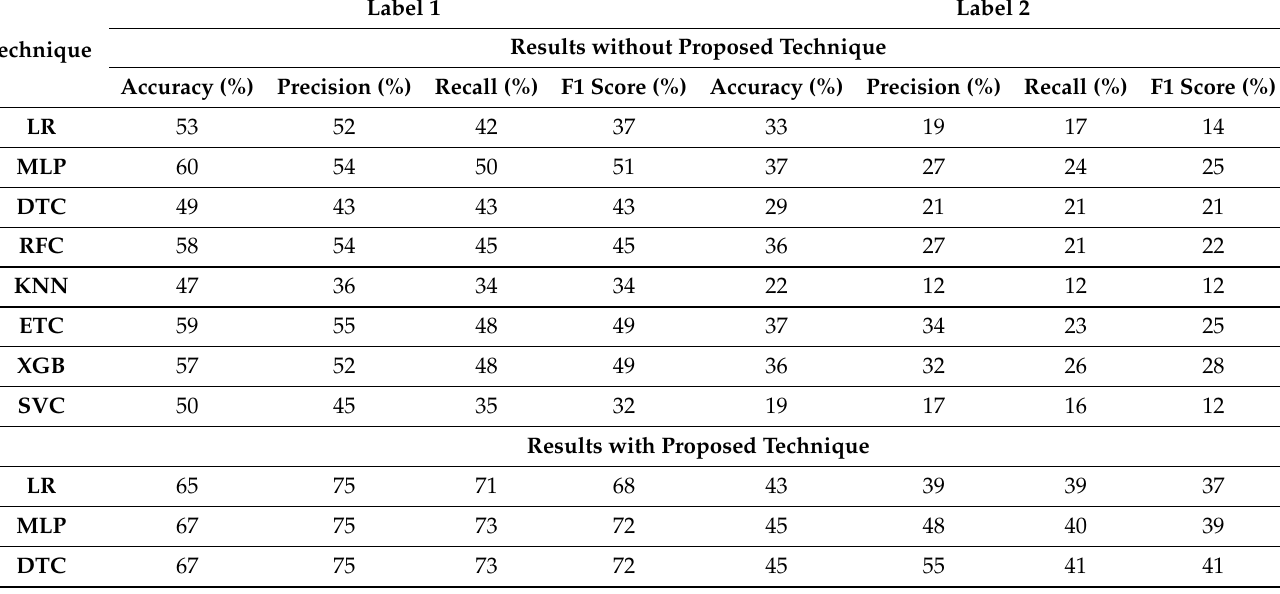
Table 6. Performance analysis of machine learning models using an imbalanced dataset with a data split of